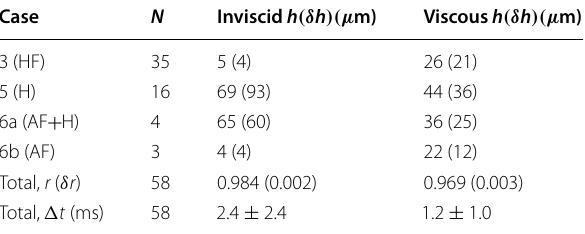
Table 1 Film thickness h (standard deviation δ h ) calculated by O ( 1 − 10 ) µ Our results indicate that h = m for both fitting R a ( t ) ( φ = 0.4 suspension) to inviscid and viscous models. models and that the inviscid model gives a better fit HF : high-frequency wave; H : Helmholtz resonance; AF : air flow; (larger r and a longer (cid:31) t ). This result is consistent with N : number of runs used; r : correlation coefficient (standard those of Kobayashi et al. (2010), who obtained the h of deviation δ r ); (cid:31) t : Time span used for the fit. In terms of N , the bubbles bursting in a syrup solution with a comparable inviscid model gives a higher r for 69 % of the runs viscosity of η ≃ 1.9 Pas. The values in Table 1 indicate Case N Inviscid h (δ h )(µ m) that the h estimated for cases 5 and 6a (Helmholtz reso- nance) are thicker than those estimated for cases 3 (HF wave) and 6b (air flow) as a result of smaller v a . We note that the estimated h is comparable to or larger than the particle diameter ( d p ≃ 2 µ m) suspended in the liquid. From the viscous model, we obtained h / d p ∼ 11 − 22 . Total, (cid:31) t (ms) 58 2.4 ± 2.4 1.2 ± This model uses suspension viscosity η , which assumes O ( 10 ) a continuum. However h / d p = suggests that this